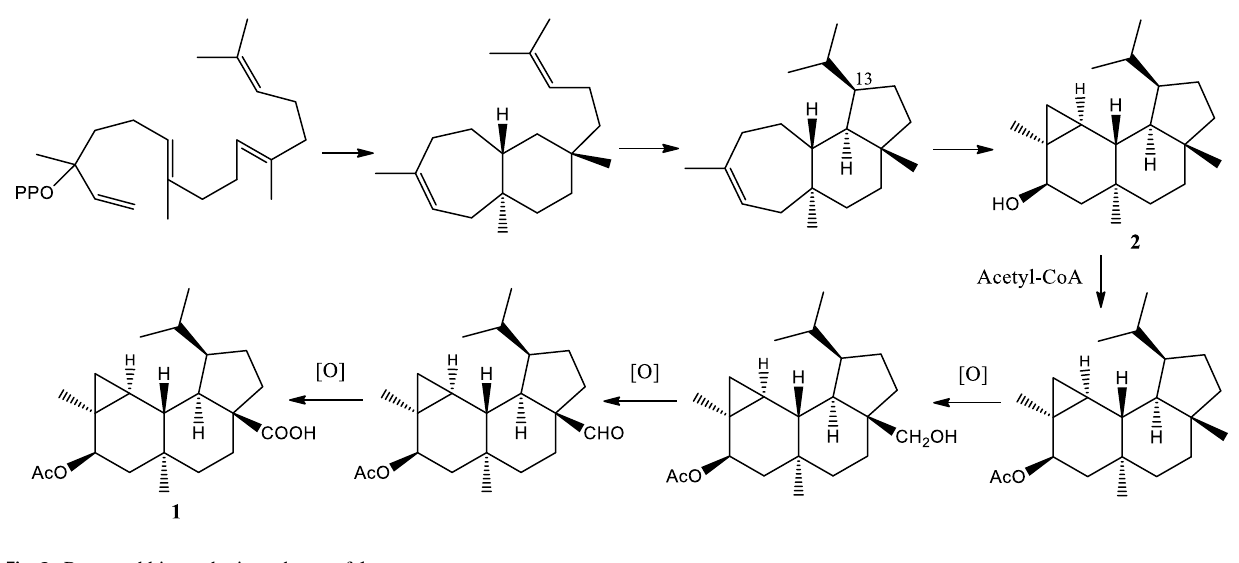
Fig. 3 Proposed biosynthetic pathway of 1 Table 2 The MIC (μg/mL) of 1 – 4 against six fungal strains